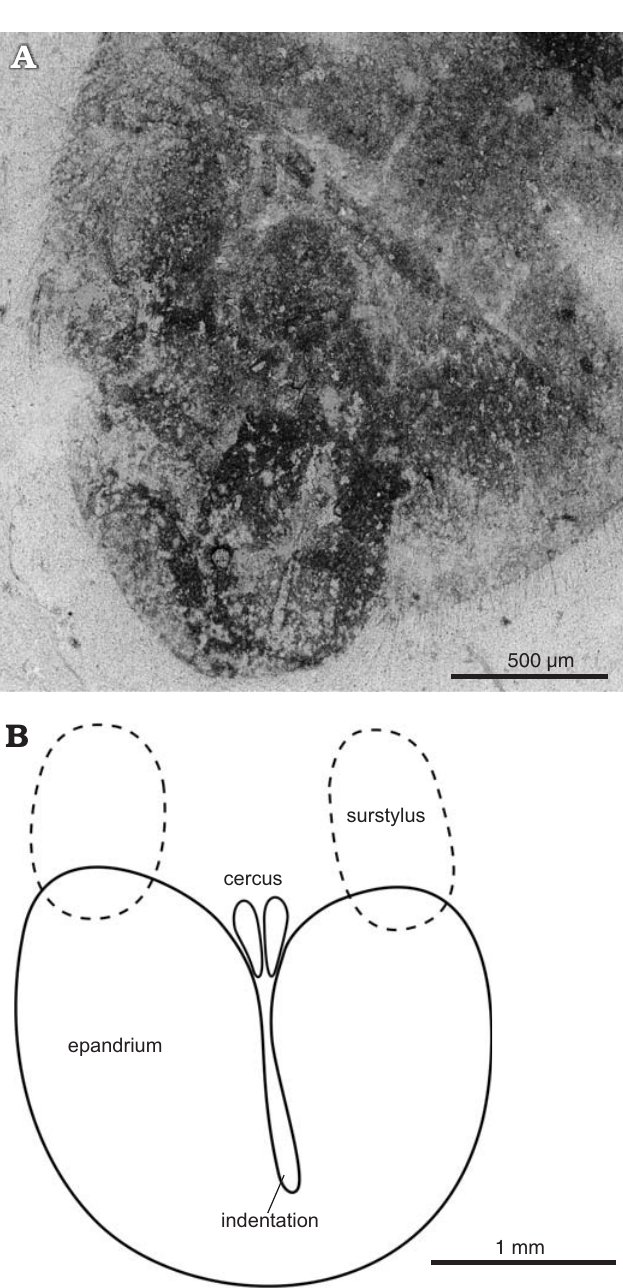
Fig. 6. Pipizine hovefly Oligopipiza quadriguttata Nidergras, Hadrava, and Nel gen. et sp. nov., holotype RNGL-S01, Rupelian, Céreste. Male epandrium. ESEM photograph ( A ), reconstruction ( B